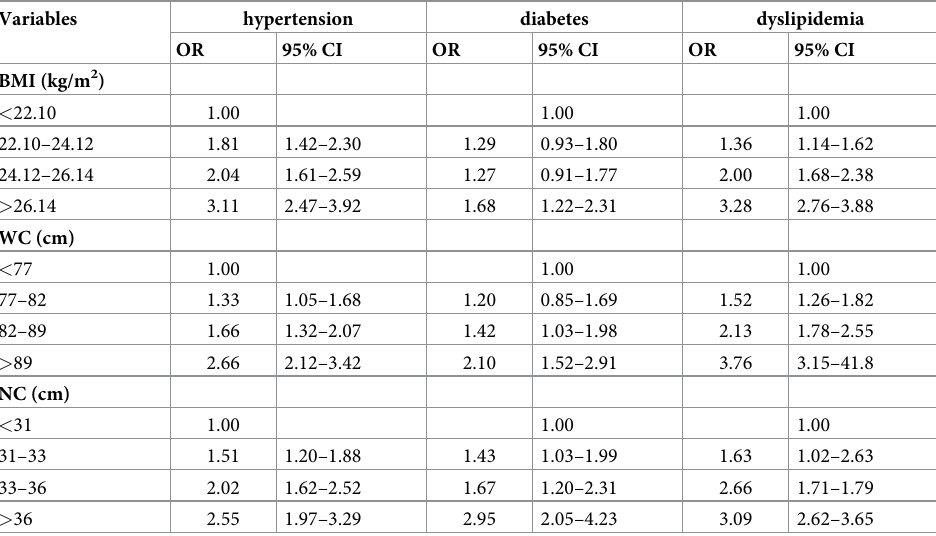
Table 3. The relationship between BMI, WC, NC and the prevalence of new hypertension, diabetes and dyslipidemia.